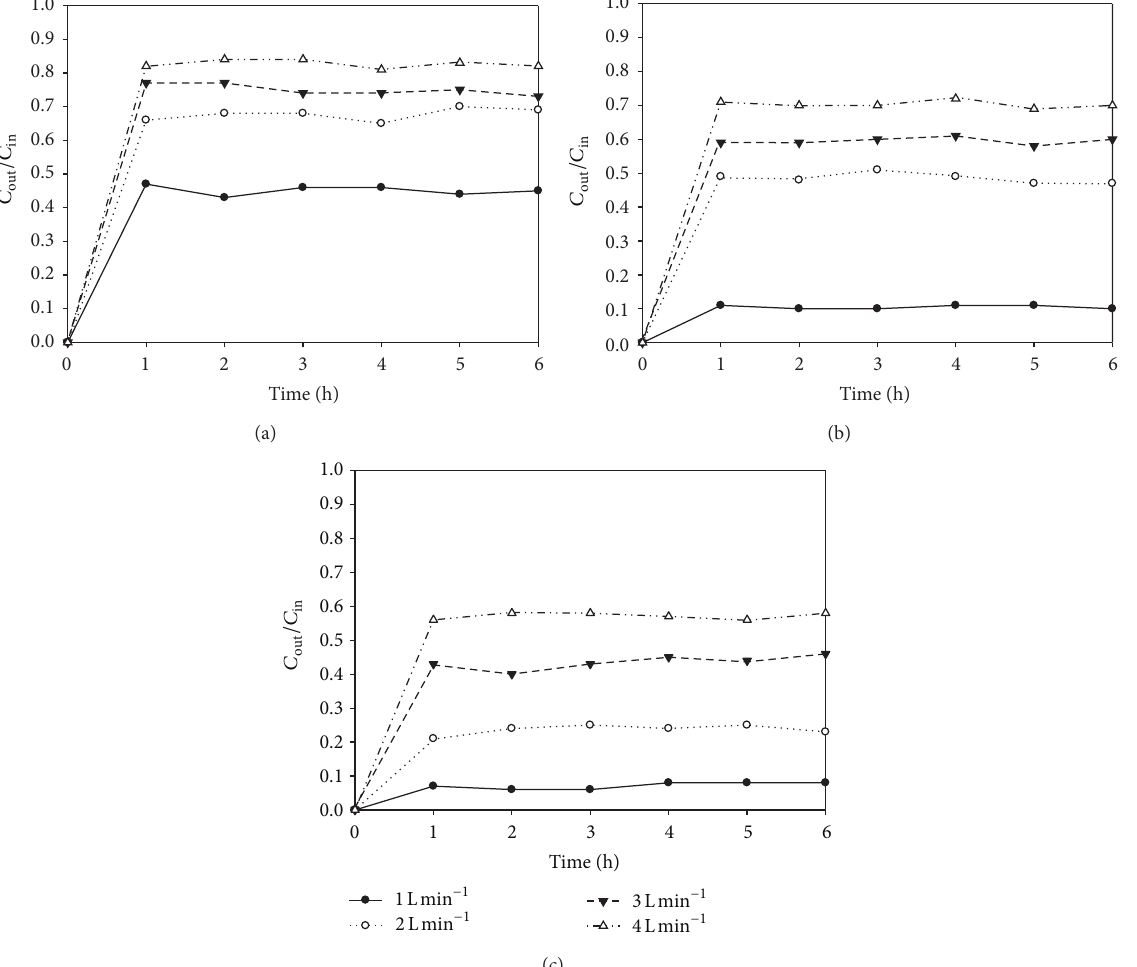
/𝐶 Figure 7: Time-series ratios ( 𝐶 ) of outlet-to-inlet concentrations of (a) toluene, (b) ethyl benzene, and (c) o-xylene as obtained using out in GF-N-TiO 2 -0.08 according to air-stream flow